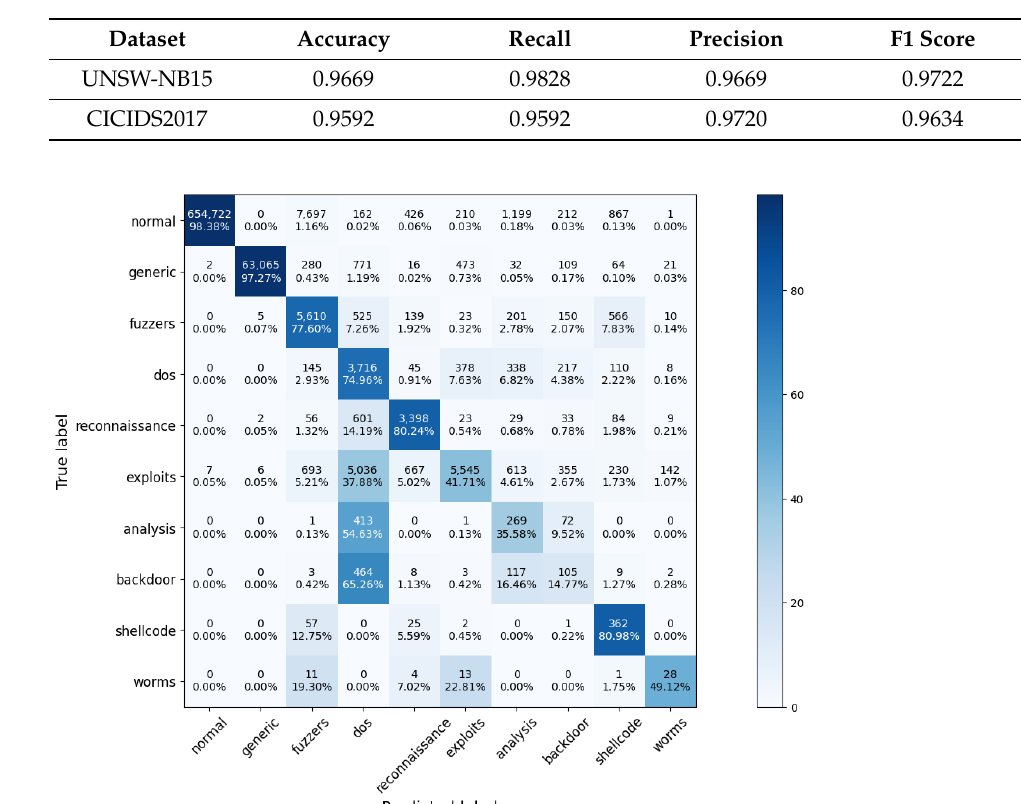
Table 1. The attack detection performance of IMIDS.